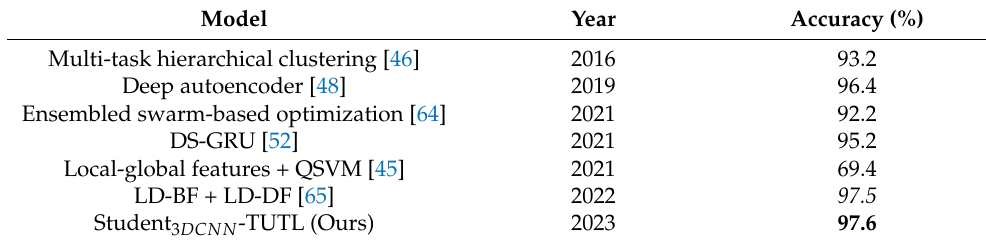
Table 9. Quantitative comparative analysis of our proposed method with the state-of-the-art action recognition methods on UCF50 dataset.